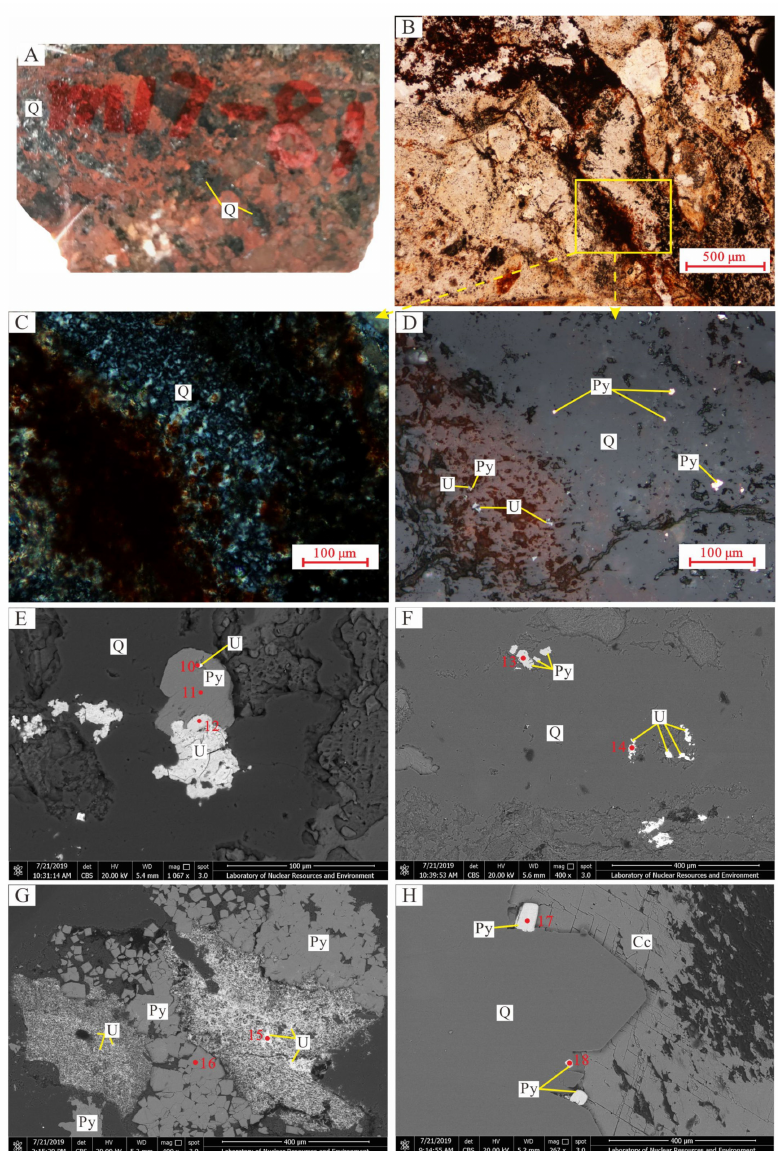
Figure 6. Cataclastic altered granite-related uranium ore. ( A ): Rock breccia is deep red and filled with microcrystalline quartz. ( B ): Chalcedony microcrystalline quartz veins filled between breccias. ( C , D ): Chalcedony microcrystalline quartz veins are mainly composed of microcrystalline quartz (Q), powdered rock debris, pyrite (Py), and uranium mineral (U). The powdered rock debris around uranium minerals presents a “red halo” phenomenon. Pyrite (Py) with good crystalline morphology develops an internal “red halo” between microcrystalline quartz grains. ( E , F ): Pitchblende and pyrite are embedded or independently distributed in microcrystalline quartz veins. ( G ): Uranite (U) and pyrite (Py) aggregates grow alternately in the fracture. ( H ): Pyrite (Py) with good crystal morphology crystallized between quartz (Q) and calcite minerals (Cc) in the mineralization stage. ( B ): 5 × , Single-polarized light; ( C ): 20 × , Cross-polarized light; ( D ): 20 × , Reflected-light. ( E – H ): SEM images. ( A – F ) sample No. M17-81; ( G ) sample No. M17-61; and ( H ) sample No. M17-5. Graph surface digital representation energy dispersive spectrum measuring point